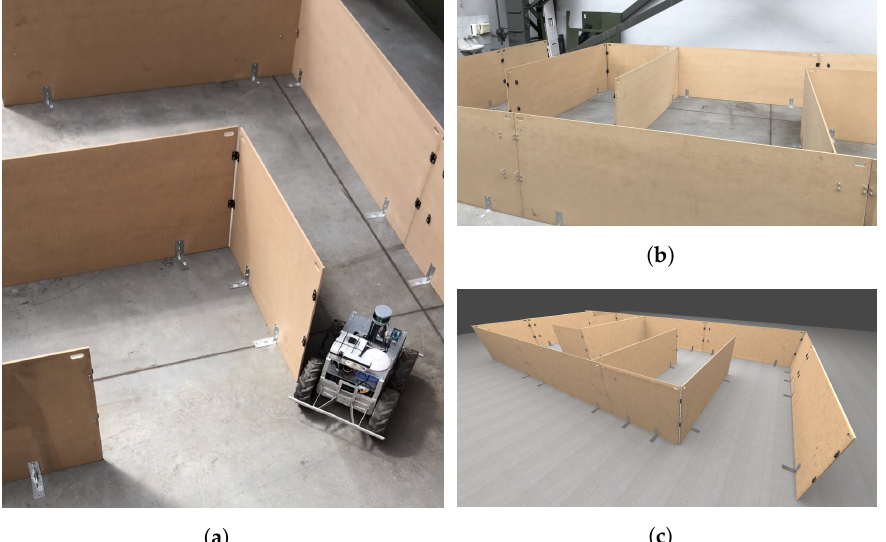
Figure 4. A real-world track (labyrinth) built for the purpose of the evaluation and the corresponding simulation. ( a ) A photo of an actual track; ( b ) A photo of an actual track; ( c ) A screenshot of a simulated track.